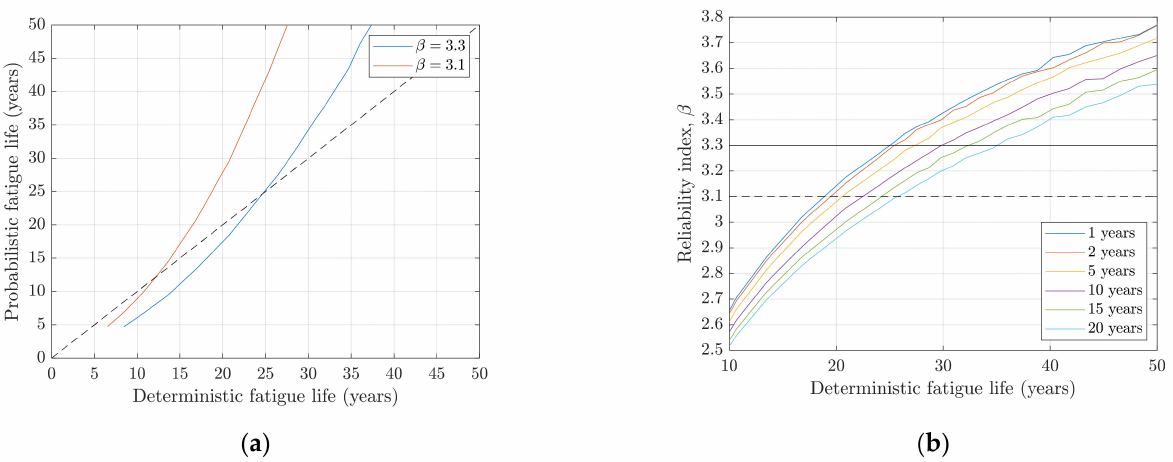
Figure 5. Effect of deterministic fatigue life on: ( a ) fatigue life from probabilistic assessment for β = 3.3 and β = 3.1 found by variation of the design parameter z ; ( b ) reliability index β in last year of the extended life for life extension periods: 1, 2, 5, 10, 15, and 20 years. The scatter for high reliability indices reflects the uncertainty related to the use of Monte Carlo